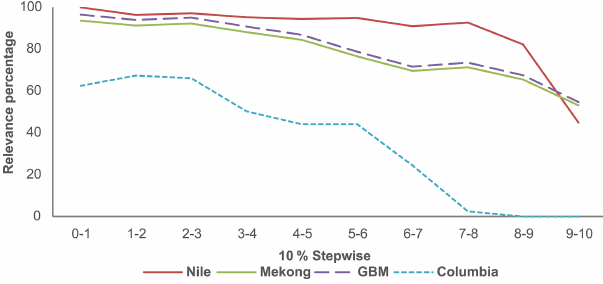
Figure 5. Relevance percentage in 10% stepwise increments for the four